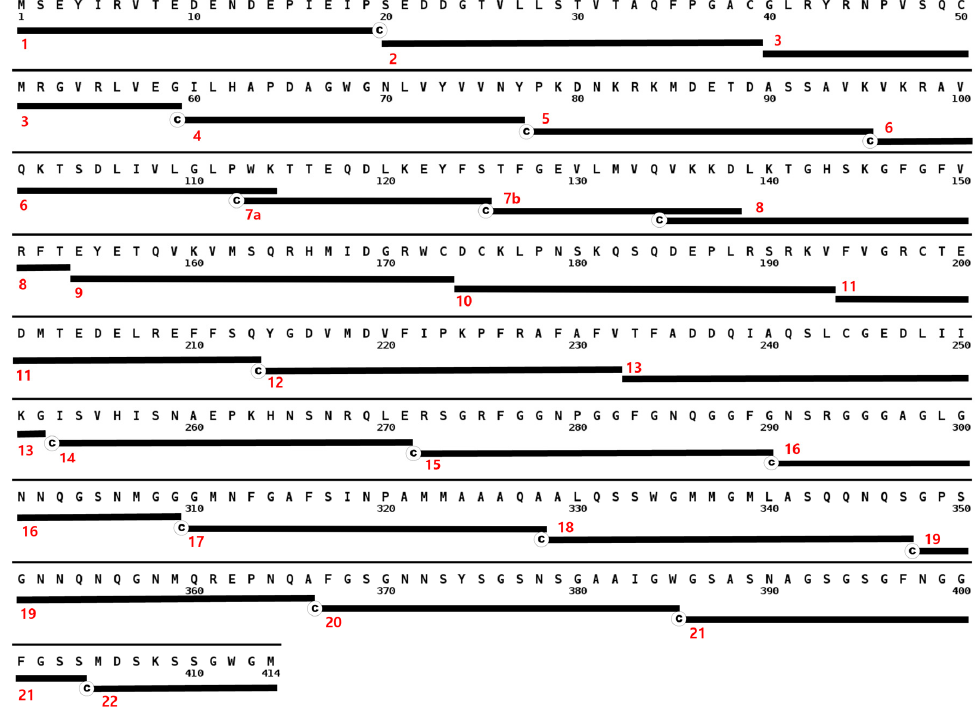
Figure 1. Synthesized TDP-43 peptides aligned with the complete sequence of TDP-43. The sequence starts with the N-terminus at the upper left corner of the figure and ends with the 414th residue at the bottom. Peptides are represented by black bars with cysteine tags and are numbered at the left.